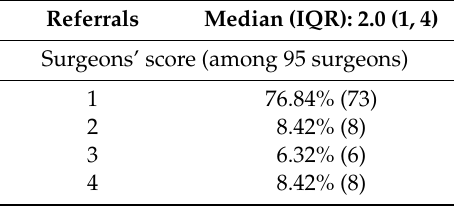
Table 2. Referral Surgeons’ score.